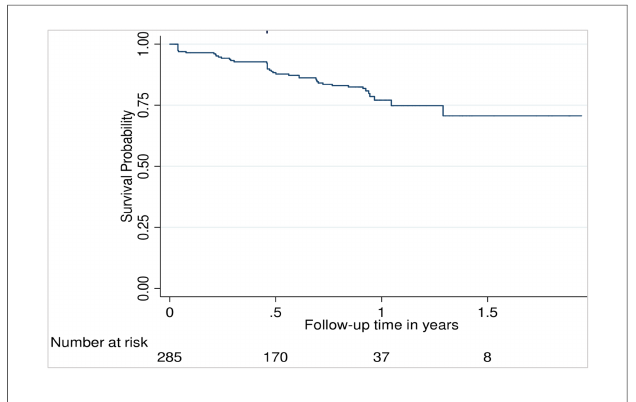
FIGURE 1 Incidence of pregnancy among adolescent girls and young women during study follow-up (2019 – 2020).